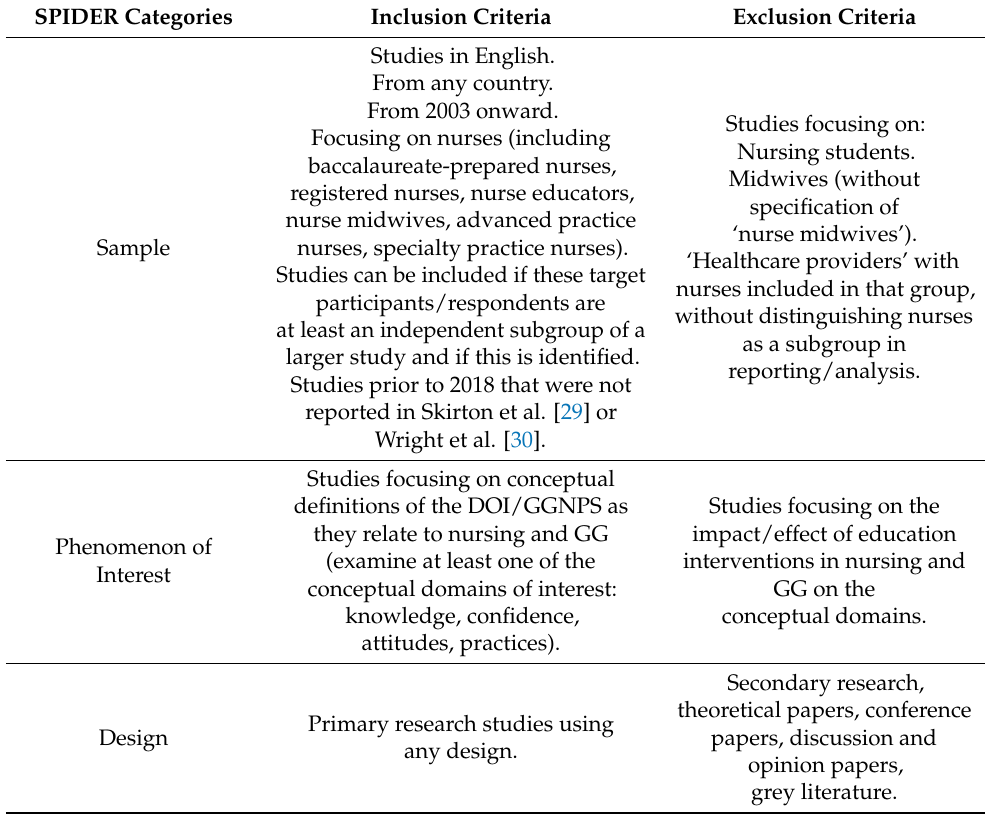
Table 2. SPIDER framework domains for study inclusion and exclusion